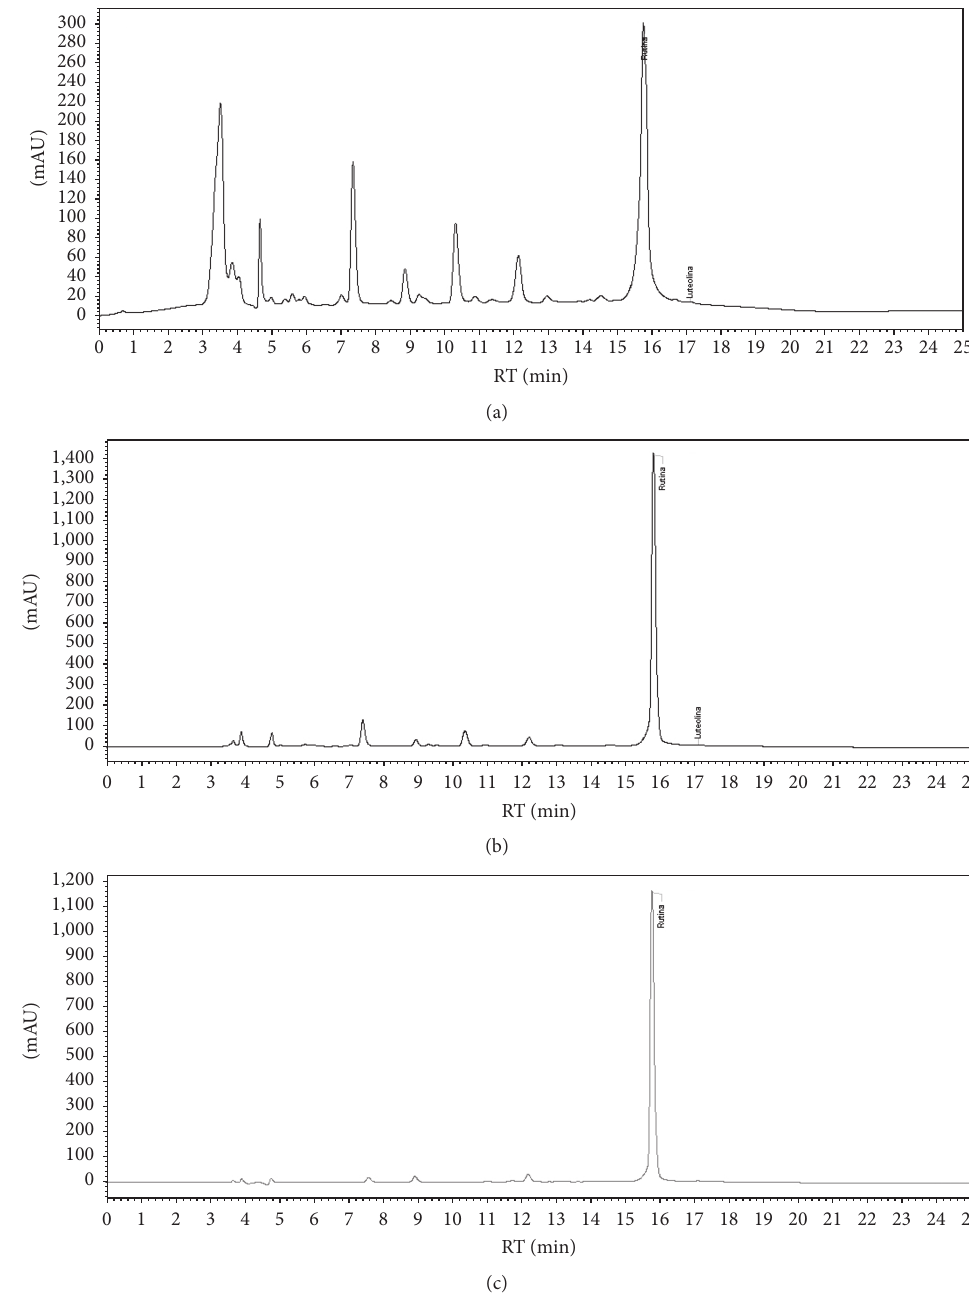
Figure 2: High-performance liquid chromatography (HPLC) of the aqueous extract of Hibiscus sabdariffa . (a) Coelution of H. sabdariffa extract, RT = 15.74 min 254 nm, (b) coinjection of standard rutin, RT = 15.78 min 254 nm and (c) rutin, RT = 15.74 min 360 nm. Table 2: Mean body weight (g) and weight gain (mean ± SD) for rats treated for 15 days with aqueous extract of H. sabdariffa L. Treatment